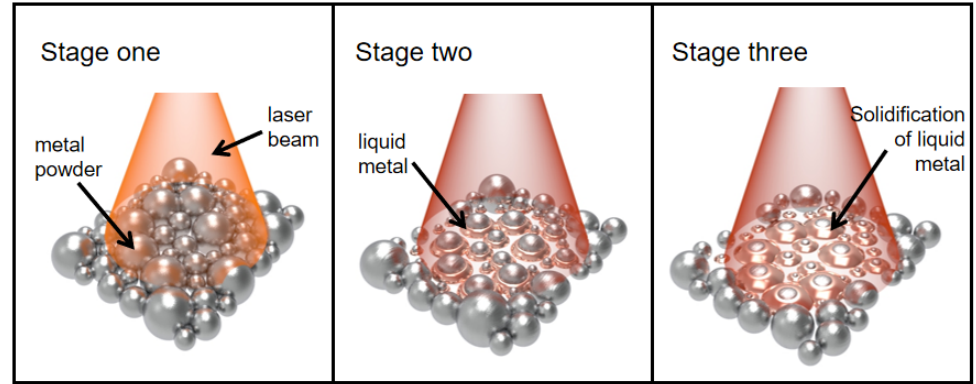
Figure 7. Schematic diagram of the pore formation mechanism.